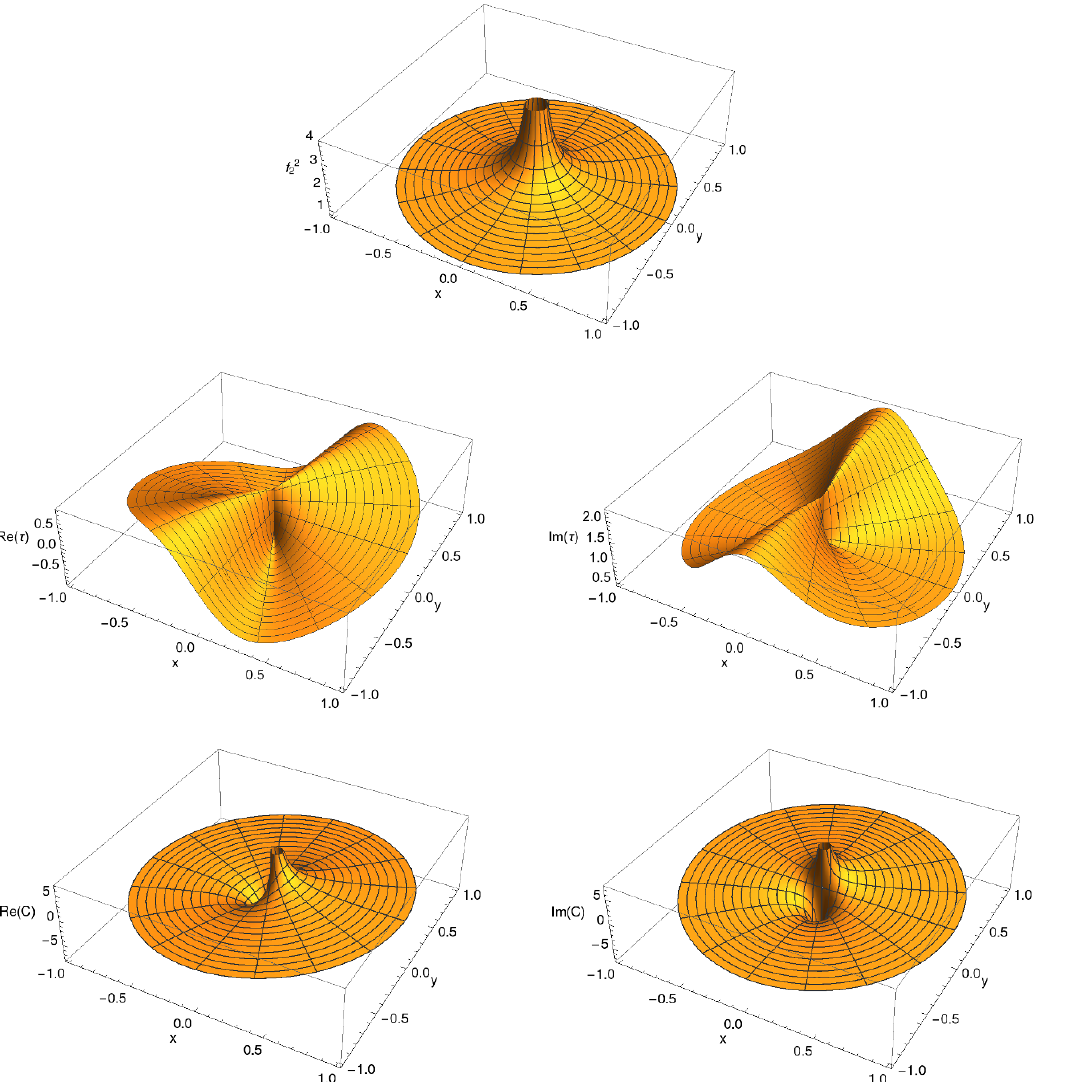
Figure 1 . The metric factors, axion-dilaton, and two-form (cid:12)elds for the minimal solution with a single interior pole of order two. We have chosen & = ~ A 0 all take the same qualitative form, we display only f 2